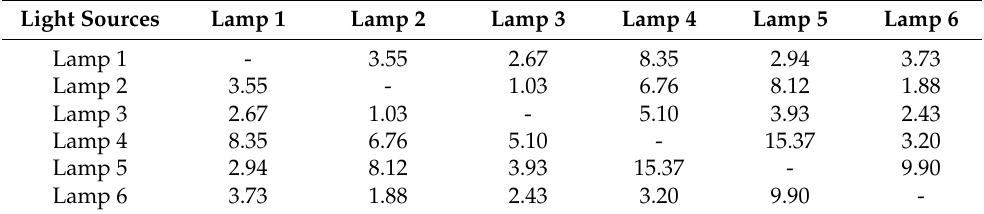
Table 2. Calculated ∆ E CIE2000 between colorimetric points for mint leaves grown under all lamps. Light Sources Lamp 1